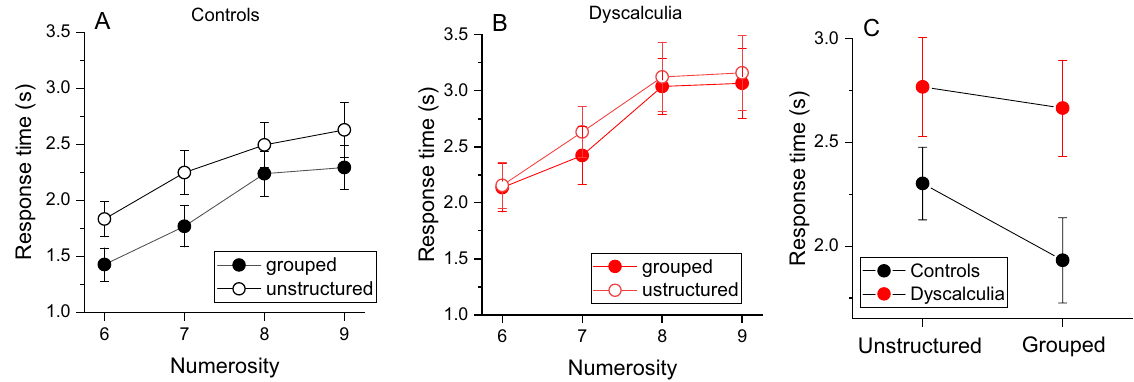
Figure 5. Groupitizing effect on response time. ( A , B ) Average response time as a function of numerosity for the two experimental conditions (empty circles: randomly spaced stimuli, filled circles: grouped stimuli). ( C ) Response time averaged across numerosity levels and participants. Error bars show ± 1 SEM.